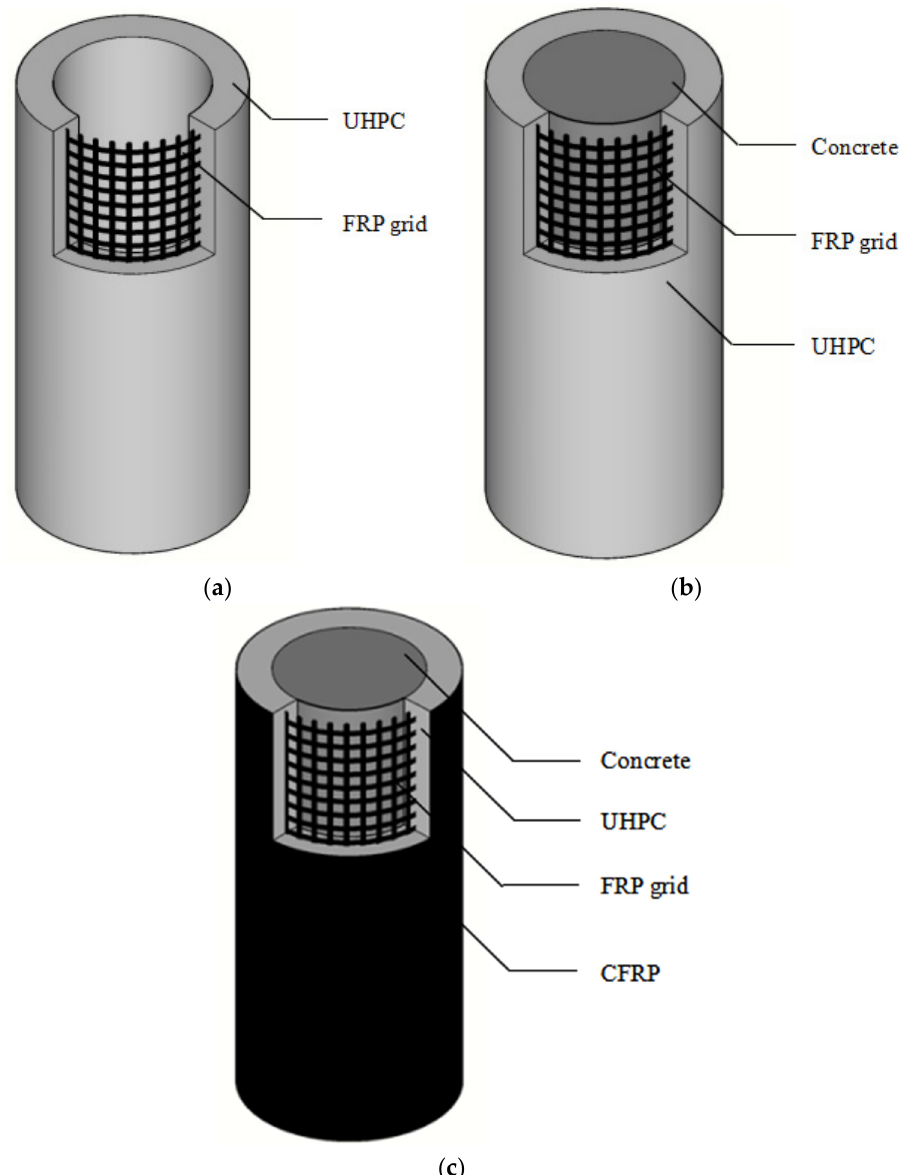
Figure 1. Three-dimensional diagram of different types of specimens. ( a ) FRP grid-UHPC tubular column; ( b ) Concrete-filled FRP grid-UHPC tube column; ( c ) CFRP-confined concrete-filled FRP grid-UHPC tube column.